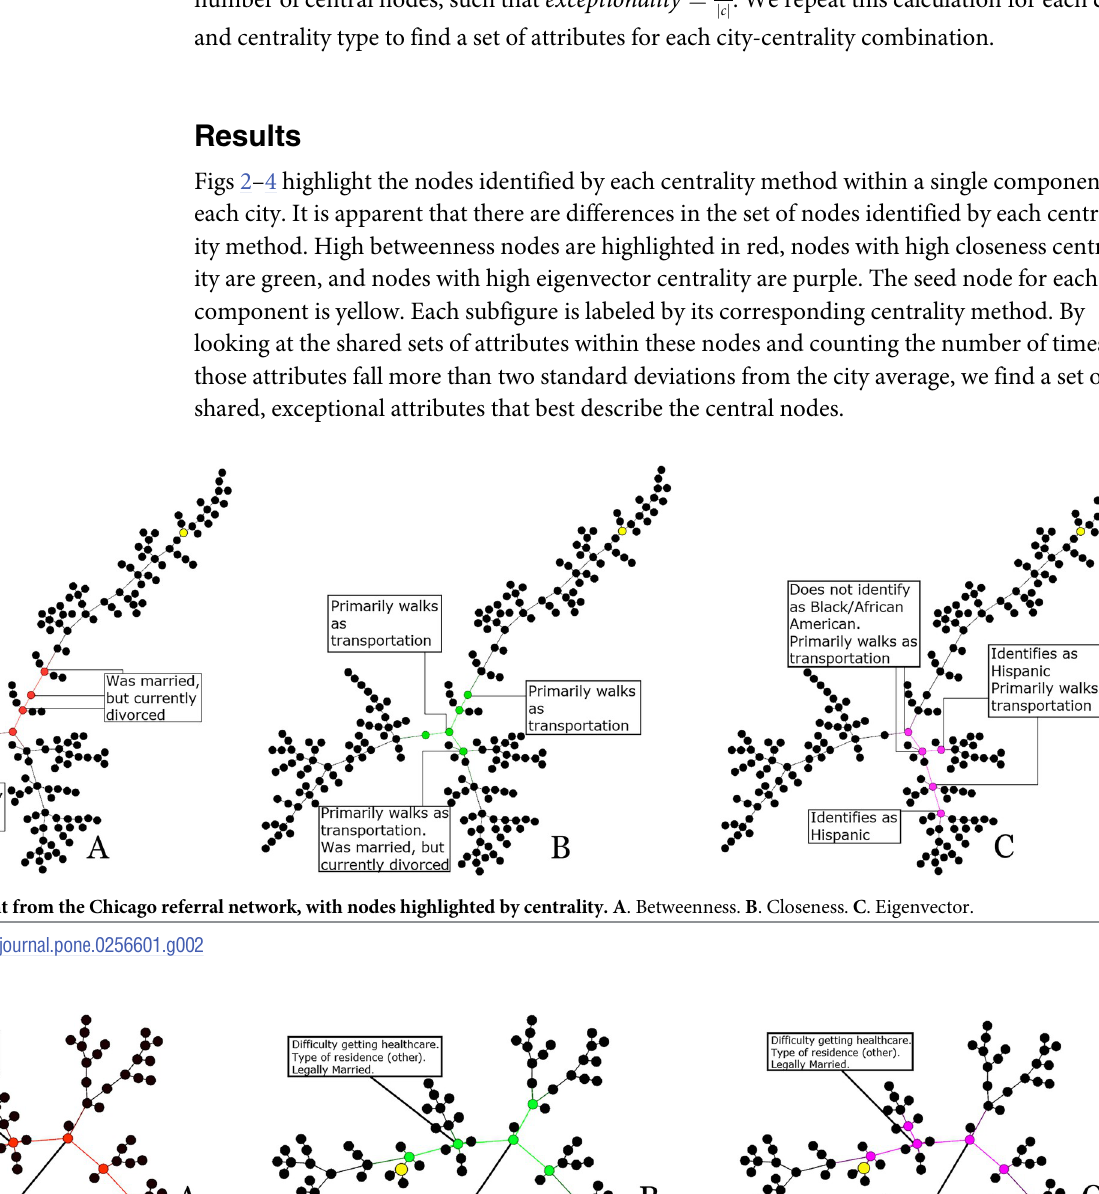
PLOS ONE | https://doi.org/10.1371/journal.pone.0256601 August 24,